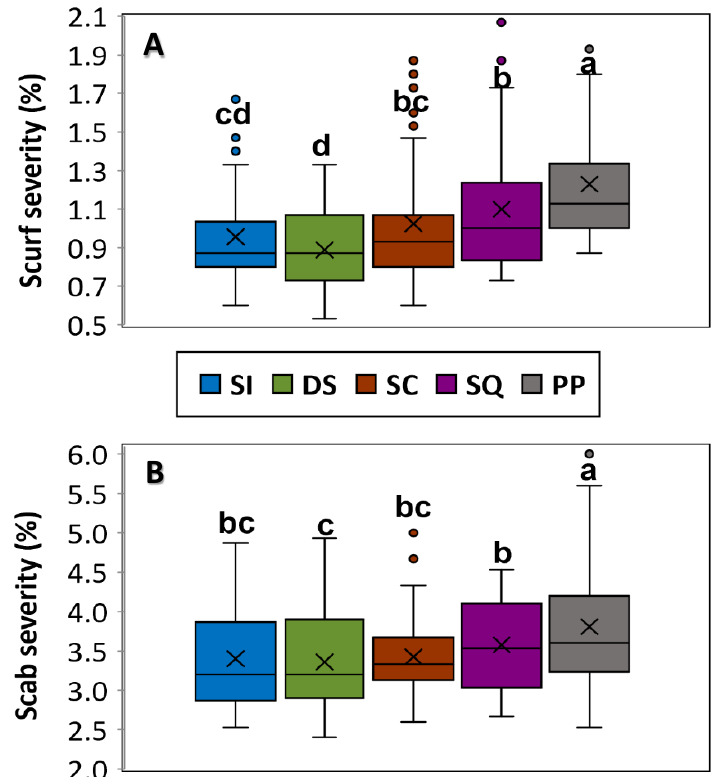
Figure 4. Effects of cropping system (SQ—standard rotation, SC—soil conserving, SI—soil improving, DS—disease suppressive, and PP—nonrotation control) on the severity (represented by percent surface coverage) of soilborne tuber diseases ( A ) black scurf and ( B ) common scab over four cropping seasons (2015–2018). Bars topped by the same letter are not significantly different from each other based on pairwise t -tests ( p < 0.05). Data points outside of the depicted range indicate outliers. The incidence and severity of common scab also varied from year to year, and DS